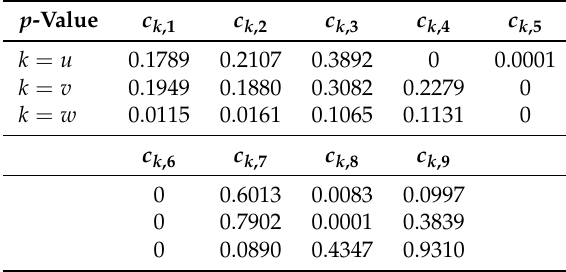
Table 12. Importance of variables in H k regression.